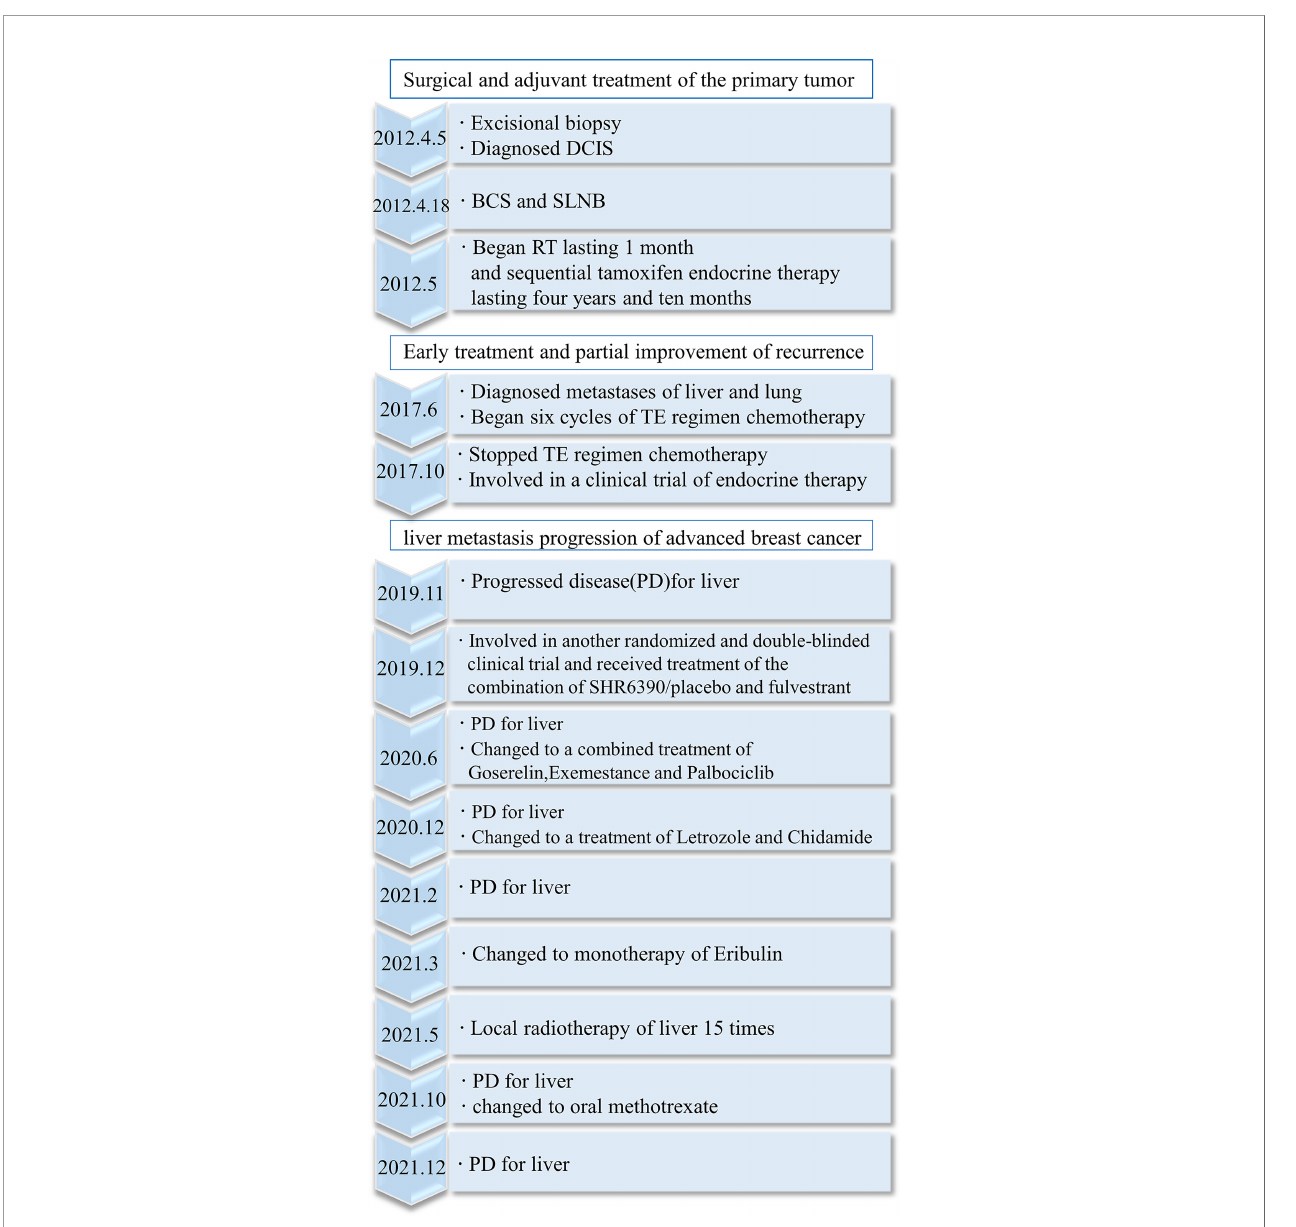
FIGURE 3 | Timeline of the patient ’ s disease